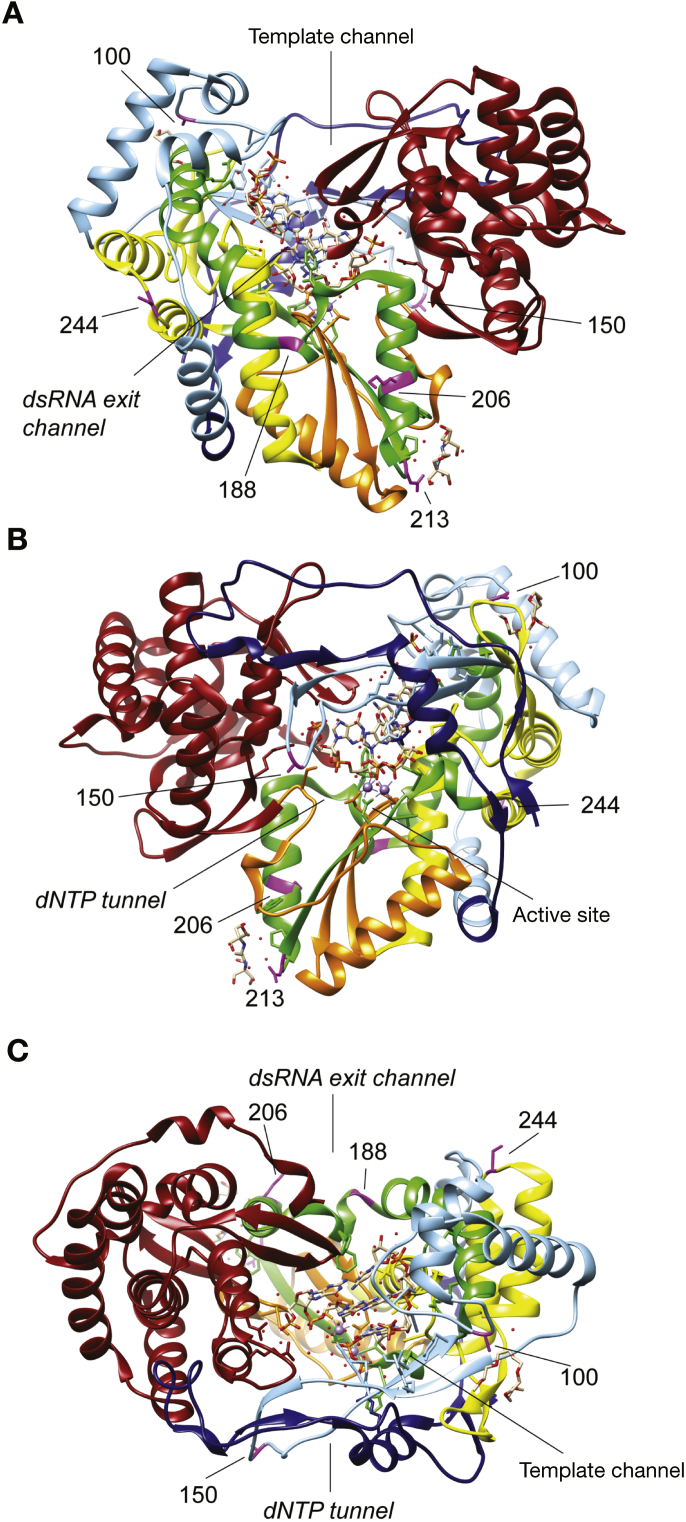
3-Dimensional model of the HCV polymerase NS5b (A, front; B, back; C, top) derived from the JFH-1 crystal structure with the location of the polymorphisms of interest shown in purple. The structure in the center represents a bound RNA strand. PDB crystal structure ID: 4WTG. Structure was annotated using the Chimera software. dNTP, deoxyribonucleotide triphosphate; dsRNA, double-stranded RNA.